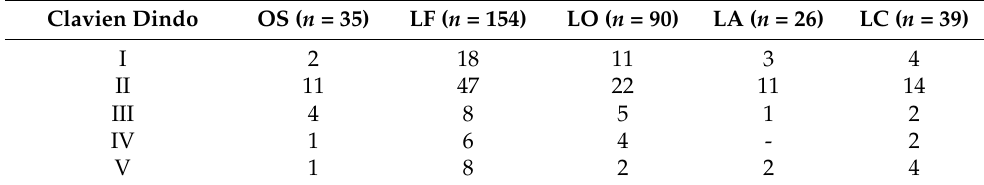
Table 1. 30-day postoperative complications following surgery for SBO. Clavien Dindo